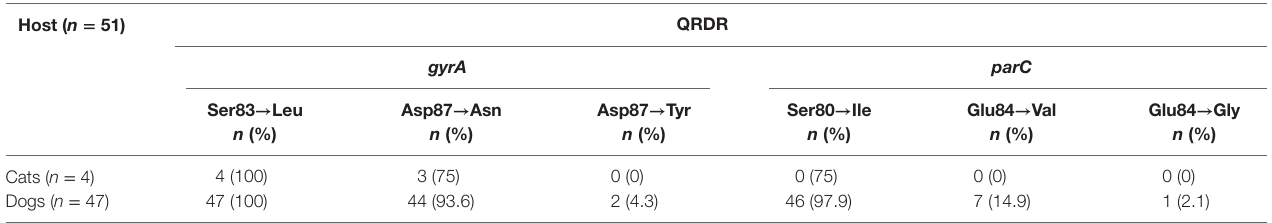
Asn, asparagine; Asp, aspartic acid; CIP, ciprofloxacin; Glu, glutamic acid; Gly, glycine; gyrA, DNA gyrase (type II topoisomerase) gene; Ile, isoleucine; Leu, leucine; parC, topoisomerase IV gene; QRDR, quinolone resistance determining region; Ser, serine; Tyr, tyrosine; Val, valine. and ST648, ST744, and new STs (each 5.2%, 3/58). E. coli ST410 and human-related pandemic clone E. coli ST131 were detected only in isolates from dogs. E. coli ST410 was isolated from 33.3% of the urine samples from